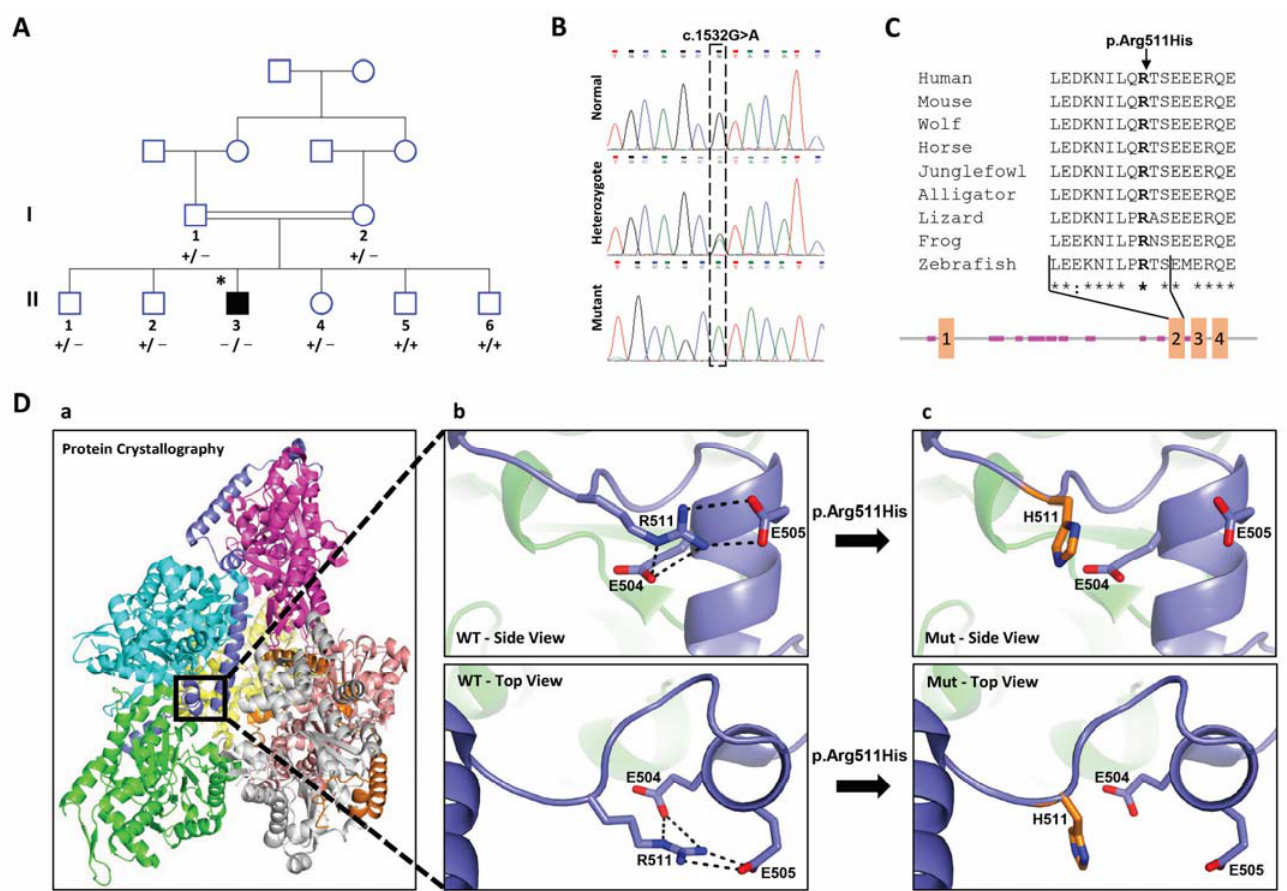
Figure 1. Family pedigree, Sanger sequencing of the mutant locus, evolutionary conservation, do ‐ main location, and 3D structure of the protein. ( A ) Pedigree and segregation of the variation in the PHACTR2 gene. The presence of the PHACTR2 variation in the family was determined by PCR am ‐ plification of the region that contains the variation. +/+ normal, − /+ heterozygous, − / − homozygous for the mutation. * Indicates an individual for whom whole ‐ exome sequencing (WES) was con ‐ ducted. Individuals in the pedigree who were not clinically assessed appear without numbers un ‐ derneath. ( B ) Example chromatograms of Sanger sequences from individuals homozygous for the variation, heterozygous, or normal. ( C ) The upper part shows the variation’s evolutionary conser ‐ vation in the protein region. The lower part consists of a diagram that shows the predicted domains, repeats, motifs, and features within Ape’s (Pongo abellii) PHACTR2 protein isoform 4 by the SMART database, thus presenting the second RPEL domain that contains the variation. Pink rectan ‐ gles represent low ‐ complexity domains, while orange represents the four numbered RPEL domains. ( D ) Modeling the 3D structure of the PHACTR2 protein using the Swiss model server. ( a ) Represents the overall 3D structure of the protein based on the mouse PDB structure 4B1Z. ( b ) Magnification of the site of the affected amino acid, Arg (the right helix part of the figure), and its hydrogen bond to the Ser amino acid. ( c ) Replacement of the amino acid Arg to His due to the variation, causing the loss of hydrogen bonds. 2.2. Identification of the PHACTR2 Variation Although the patient’s parents and five siblings were healthy, we verified the possi ‐ bility of a causative heterozygous variation. A heterozygous variation could cause DCM in the case of compound heterozygous, a de novo, or a low ‐ penetrance variation. First, we looked into the genes in which mutations were reported to cause DCM. We looked for variations in the exome results of patient II ‐ 3 in 47 genes reported to have mutations caus ‐ ing familial and non ‐ familial DCM (Supplementary Table S2) [9,21,22]. We identified three missense heterozygous variations with less than 0.1% allele frequencies in the public databases (gnomAD browser, 1000 Genomes, ExAC, and EVS) in these genes in patient II ‐